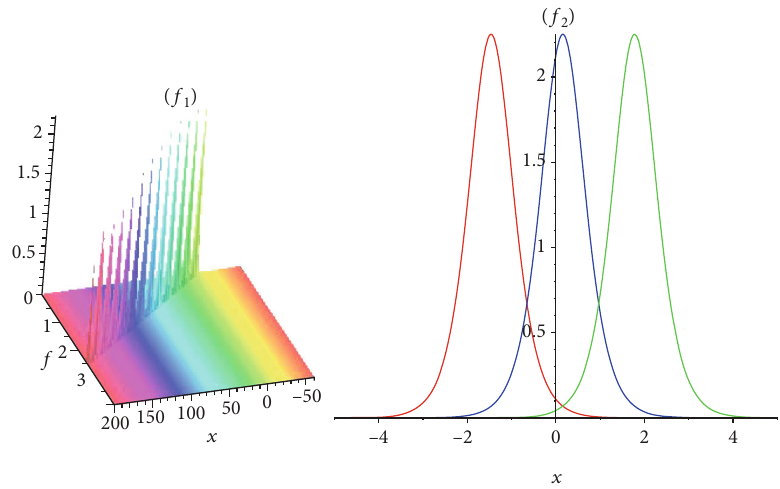
= 1, θ = 2, θ = 2, θ = : 5, θ 1 4 3 5